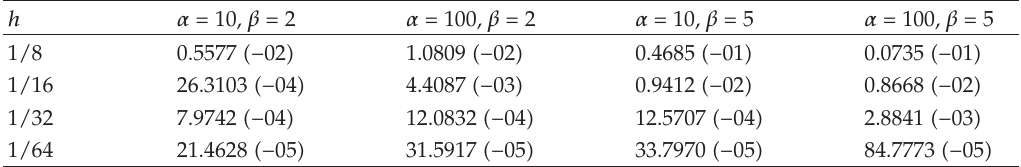
Table 11: RMS errors of scheme (cid:3) 2.5 (cid:4) .